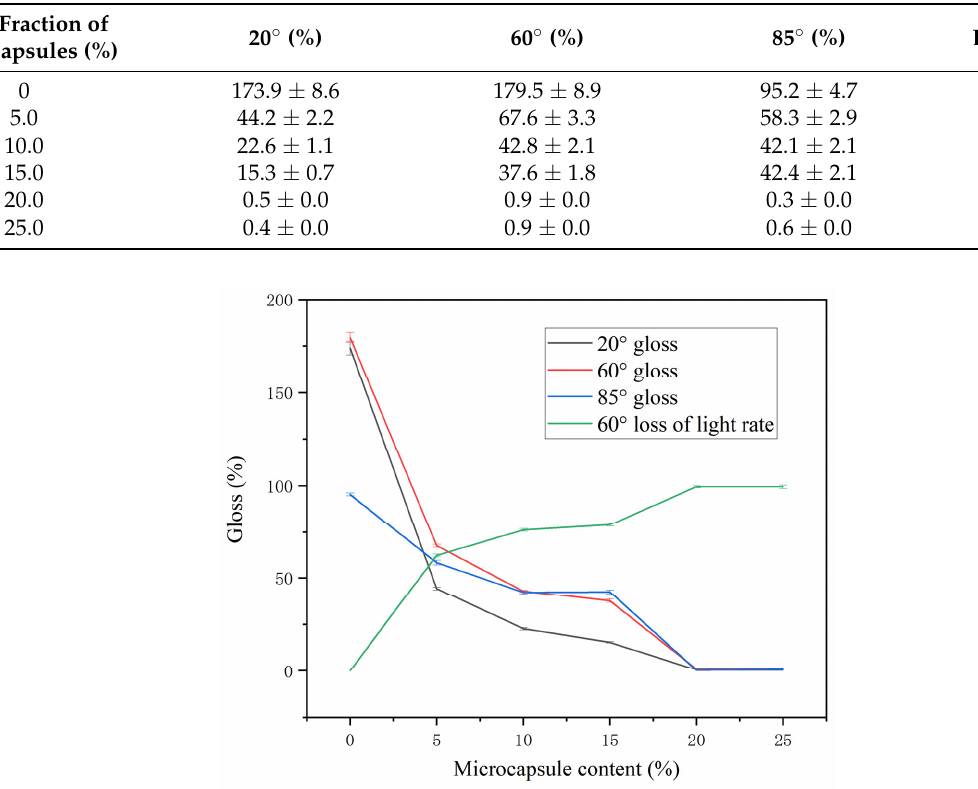
Table 9. The gloss of coating with different microcapsules content.